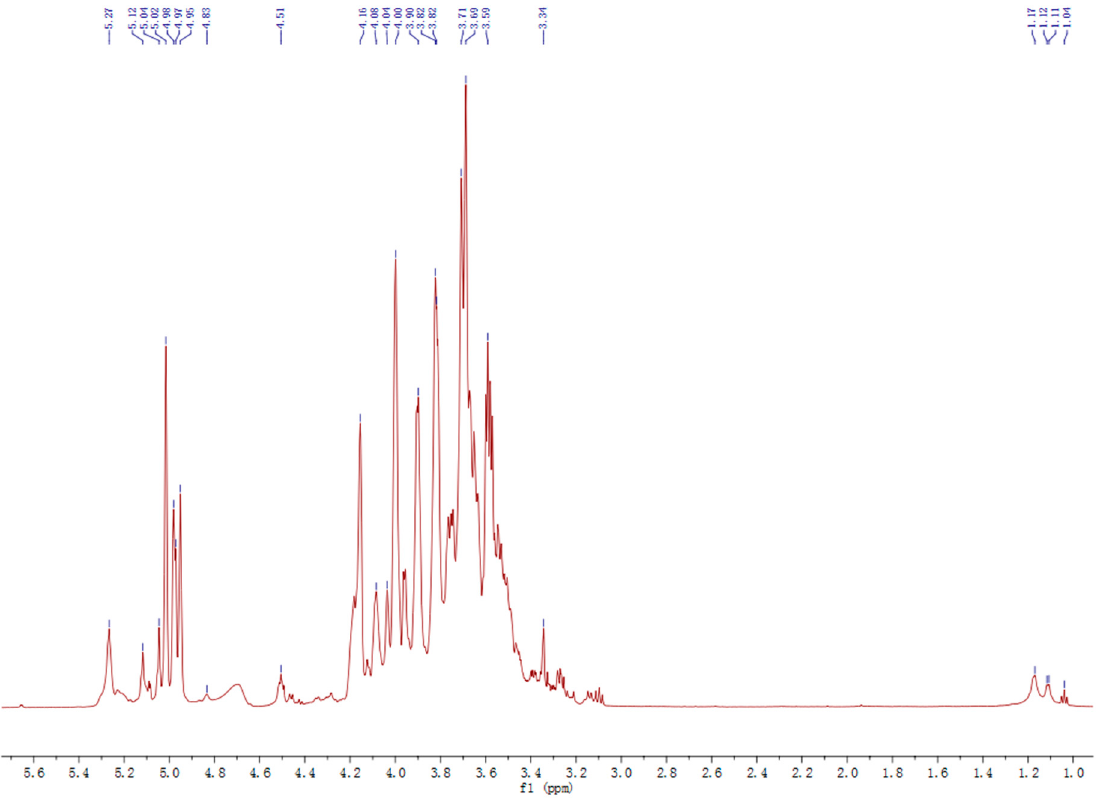
Figure 4. The 1 H-NMR spectra of polysaccharide fraction LCP-I-I.